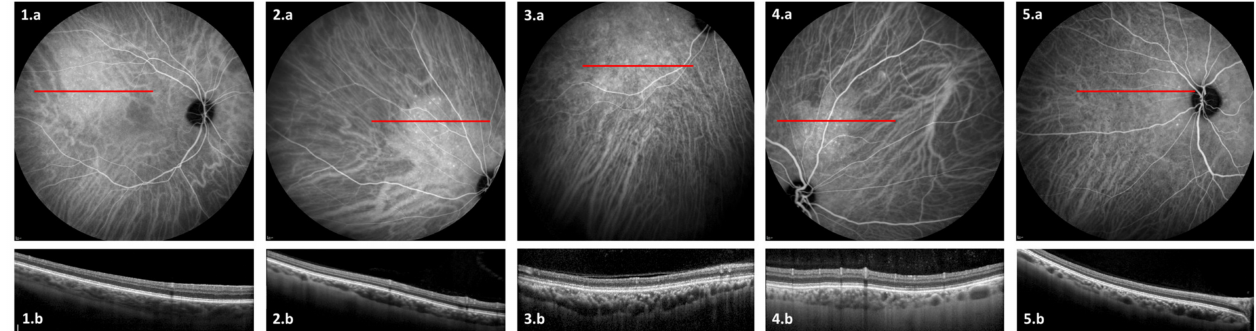
Figure 4. Intermediate phase of indocyanine green angiography (ICGA) ( 1a , 2a , 3a , 4a , 5a ) and optical coherence tomography (OCT) ( 1b , 2b , 3b , 4b , 5b ) of the 5 “hemangioma-like” lesions seen in our cohort. ICGA shows well-circumscribed hyper- fluorescent choroidal area with pinpoints, which corresponds on OCT to zones of focal choroidal thickening with dilated choroidal vessels. These lesions correspond to patients’ numbers 3 ( 1a , 1b ), 7 ( 2a , 2b ), 10 ( 3a , 3b ), 12 ( 4a , 4b ), and 14 ( 5a , 5b ),